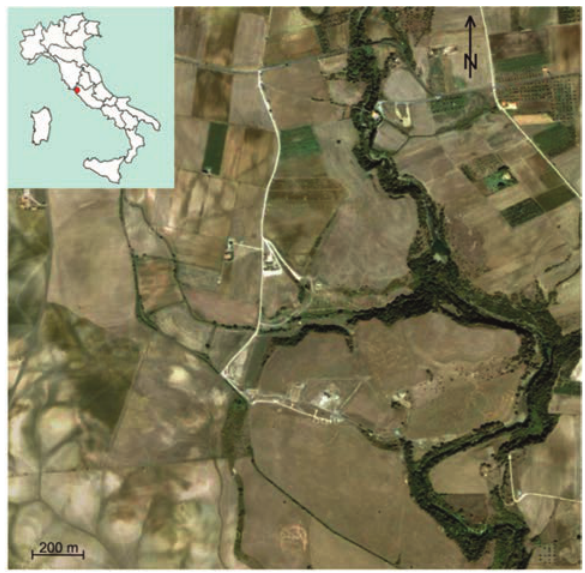
Figure 1. Area Location.